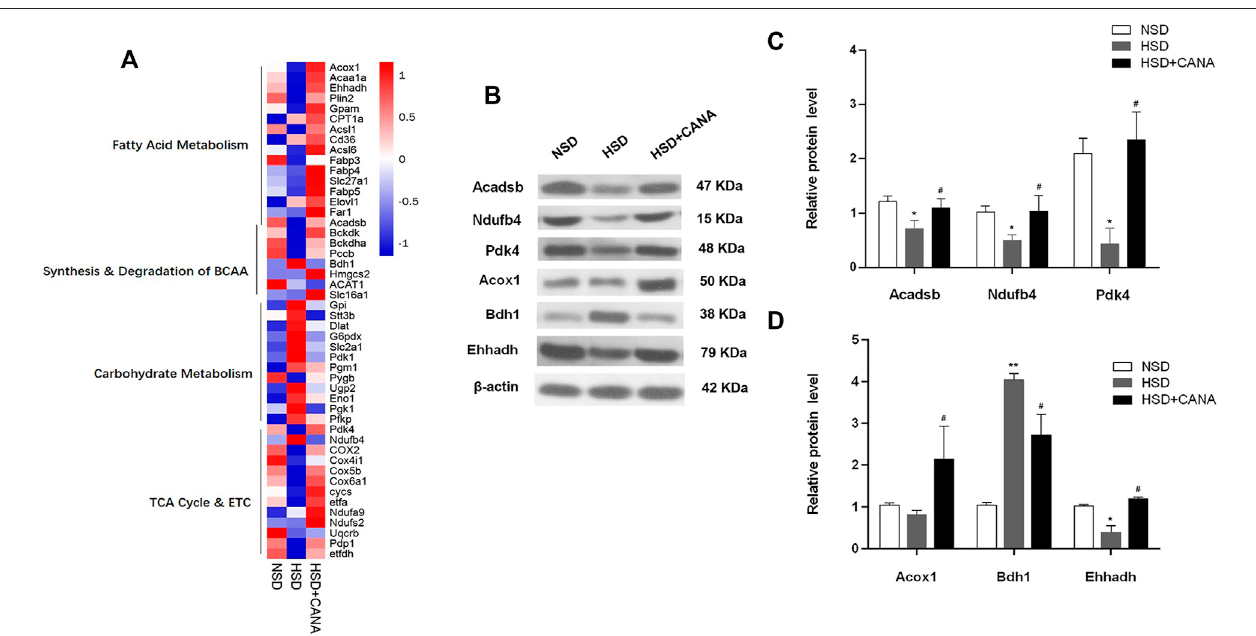
FIGURE 6 | Effect of CANA on the cardiac protein expression. (A) Heat map of individual genes within selected pathways, colored by the log2fold change; (B) Selected genes (Acadsb, Ndufb4, Pdk4, Acox1, Bdh1, and Ehhadh) were validated by Western blotting; (C,D) Quantitative evaluation of the protein expression of selected genes (Acadsb, Ndufb4, Pdk4, Acox1, Bdh1, and Ehhadh). * p < 0.05, ** p < 0.01 vs. NSD. # p < 0.05 vs. HSD.